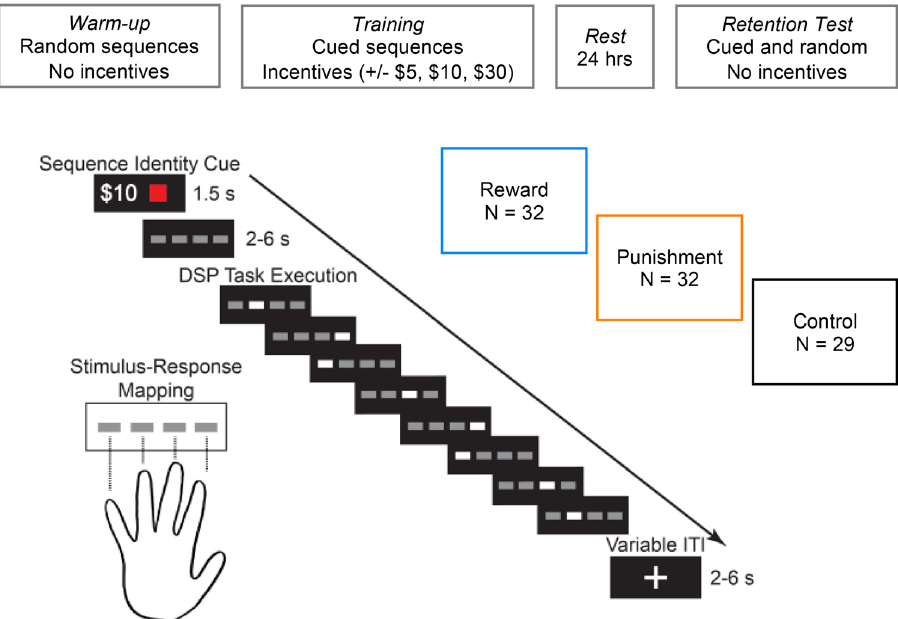
Figure 1. Experimental Design. Participants performed a discrete sequence production task with opportunities for monetary gains (reward) or losses (punishment). Each participant learned three unique 8-item sequences and each sequence was paired with an incentive of $5, $10, or $30. The control group performed the same task but without incentives. Each trial began with a cue signaling which sequence to perform (for all groups) and the size of the associated incentive (for incentive groups). Participants were instructed to perform the sequences as quickly and accurately as they could. Participants returned to the lab a day after training to test how well they retained their level of performance when incentives were no longer